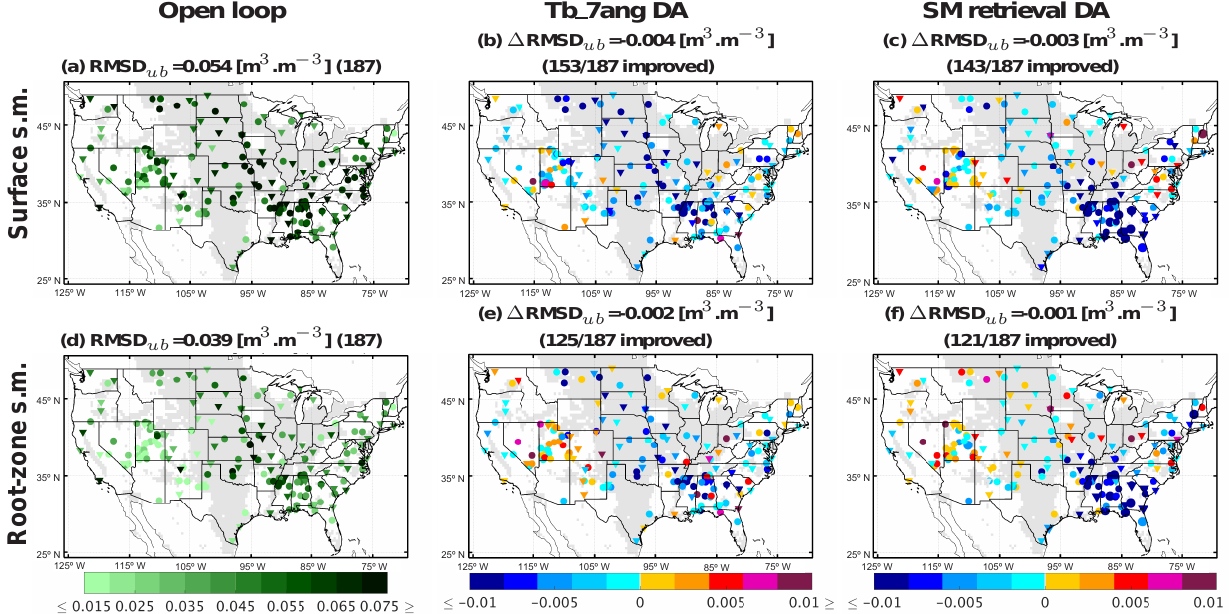
Figure 8. Unbiased RMSD (RMSD ub ) for the model-only open-loop (OL) simulation, and change in unbiased RMSD ( (cid:49) RMSD ub ) due to data assimilation at (circles) SCAN and (triangles) USCRN sites for ( a , b , c ) surface and ( d , e , f ) root-zone soil moisture. The skill of ( a , d ) the open-loop simulation is the reference value for the changes in skill due to ( b , e ) Tb_7ang and ( c , f ) SM retrieval assimilation. Statistically significant changes are marked by larger symbols (e.g., the southeastern US for SM retrieval assimilation). Metrics are calculated across 3h time steps during the period from 1 July 2010 to 1 May 2015. The titles indicate the spatial mean ( (cid:49) )RMSD ub across all sites with clustering (31 clusters). The gray background shading marks areas with limited vegetation and topographic complexity based on model